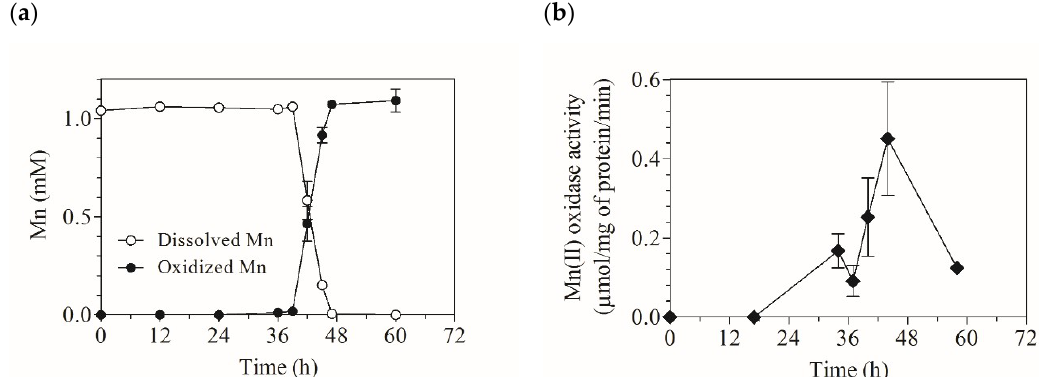
Figure 1. Mn(II) oxidation by A. strictum KR21-2 and Mn(II) oxidase activity in spent culture medium. ( a ) Formation of Mn oxides in the culture; ( b ) Extracellular Mn(II) oxidase activity of the culture supernatant. Data represent mean ± SD from duplicate experiments.